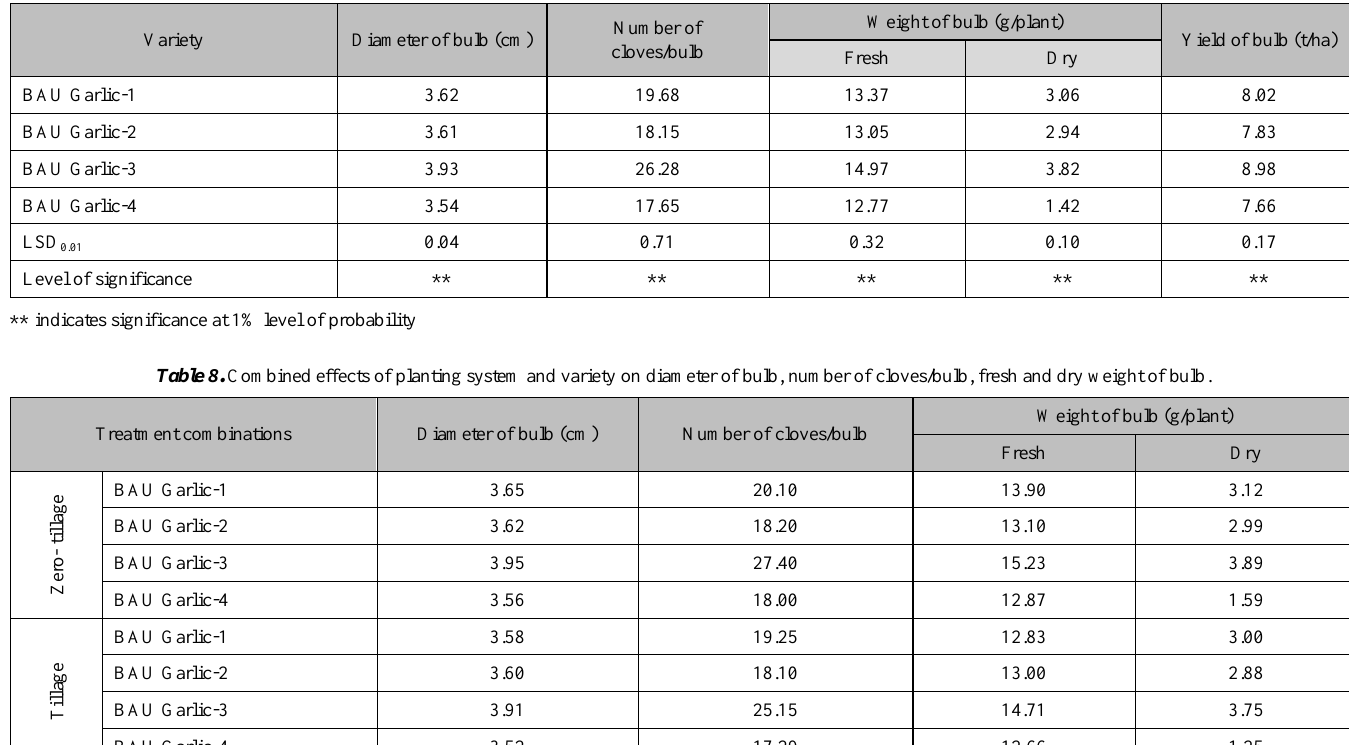
Table 7. Main effects of different variety on diameter of bulb, number of cloves/bulb, fresh weight, dry weight and yield of bulb.